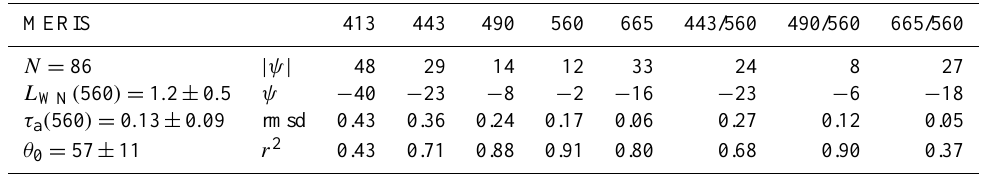
Table 2. Statistical results from the analysis of MERIS (3rd Reprocessing) and AERONET-OC L WN , and their ratios at specific center wavelengths for the match-ups determined at AAOT with 1t = ± 1h. Symbols and units are the same as in Table 1. MERIS